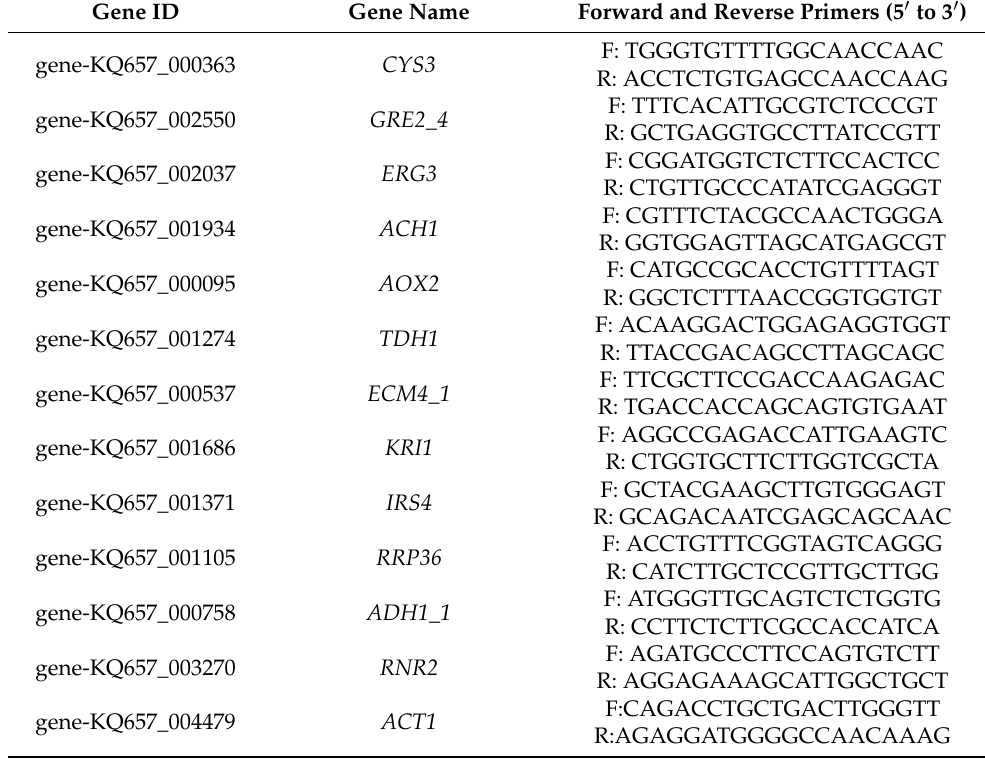
Table 1. Primers used for RT-qPCR analysis of S. spartinae